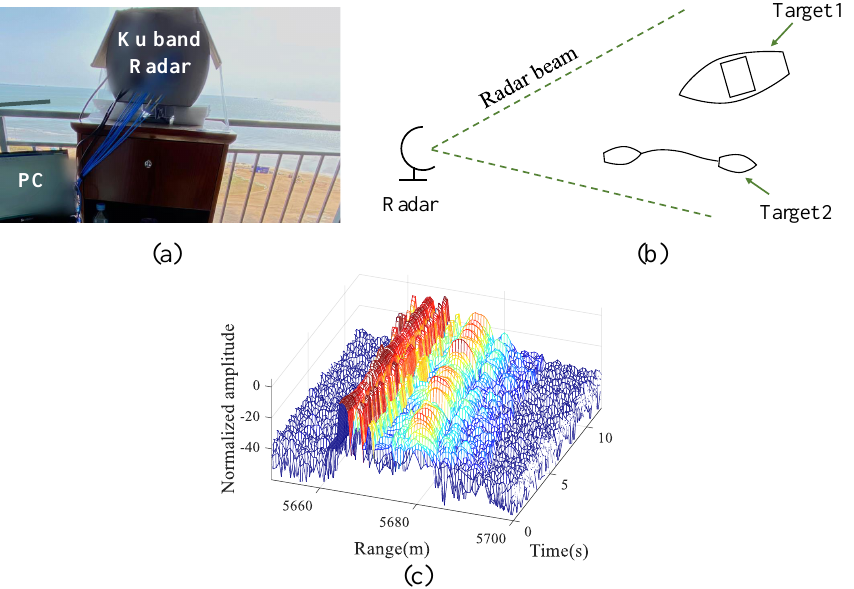
Figure 9. The experimental scenario. ( a ) The outdoor scene for the marine target detection experiment. ( b ) The positional relationship between the radar and targets. ( c ) The range–time profile of the experimental radar